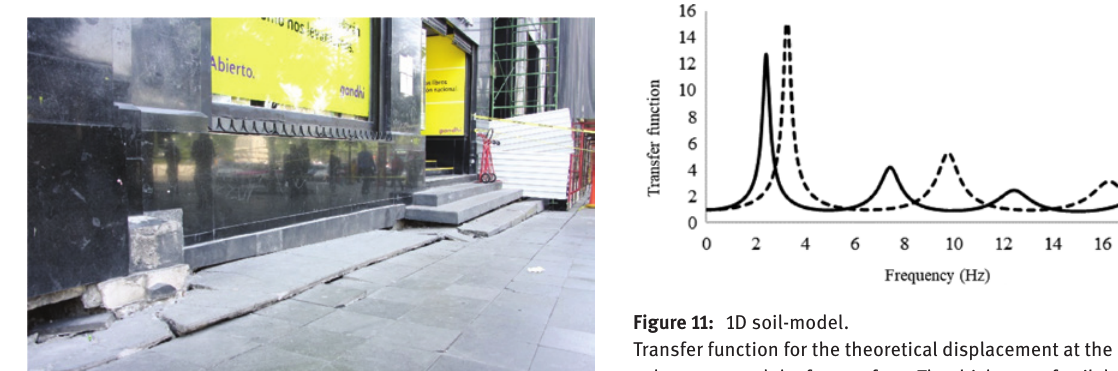
20 m. The shear wave velocity V is 200 m.s − 1 (black solid line) and s 260 m.s − 1 (black dotted line). The damping ratio is respectively 0.05 and